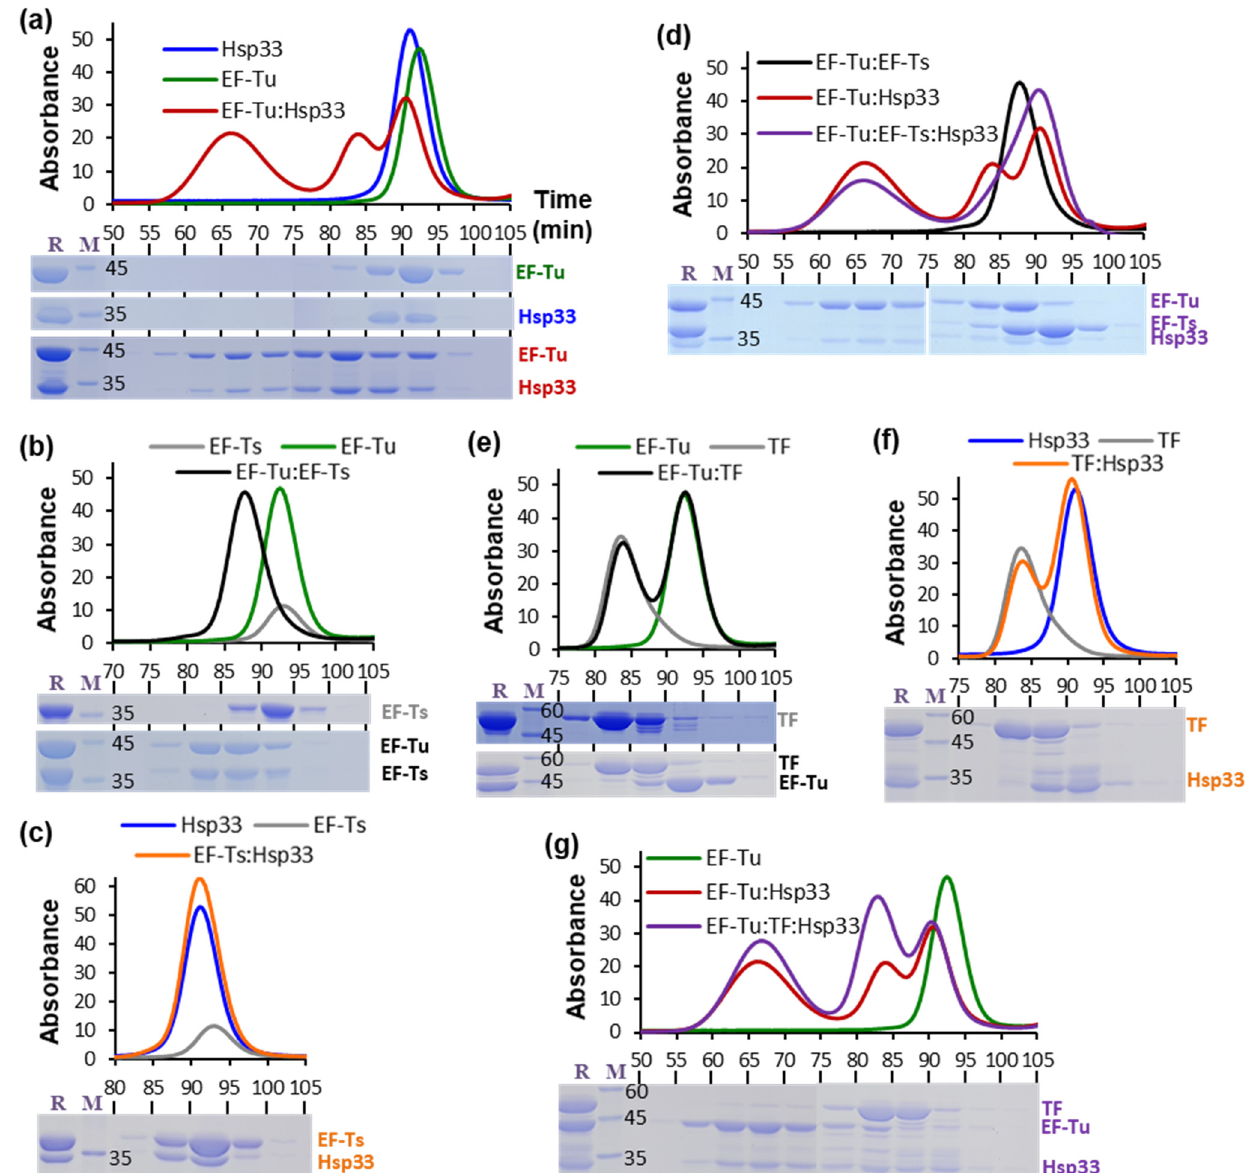
Figure 1. Oligomerization of EF ‐ Tu detected via gel filtration assay. Gel ‐ filtration (HiLoad 16/600 Superdex 200 column at 1 mL/min of flow rate) profiles are shown for EF ‐ Tu (green in a , b , e , g ), Hsp33 (blue in a , c , f ), EF ‐ Ts (gray in b , c ), TF (gray in e , f ), EF ‐ Tu:Hsp33 (red in a , d , g ), EF ‐ Tu:EF ‐ Ts (black in b , d ), EF ‐ Tu:TF (black in e ), Hsp33:TF (orange in f ), EF ‐ Tu:EF ‐ Ts:Hsp33 (purple in d ), and EF ‐ Tu:TF:Hsp33 (purple in g ). Underneath the gel ‐ filtration profiles, SDS ‐ PAGE images are shown for individual fractions of gel filtration (lane R, mixture of the individual proteins before incubation; M, molecular size marker in kDa): EF ‐ Tu ( a ) Hsp33 ( a ) EF ‐ Ts ( b ) TF ( e ) EF ‐ Tu:Hsp33 ( a ) EF ‐ Tu:EF ‐ Ts ( b ) EF ‐ Tu:TF ( e ) EF ‐ Ts:Hsp33 ( c ) TF:Hsp33 ( f ) EF ‐ Tu:EF ‐ Ts:Hsp33 ( d ) and EF ‐ Tu:TF:Hsp33 ( g ). Sample solutions for the gel filtration contained 0.1 mM of each protein, which was pre ‐ incubated at 35 ° C for 30 min before loading (1 mL of injection volume) onto the column.